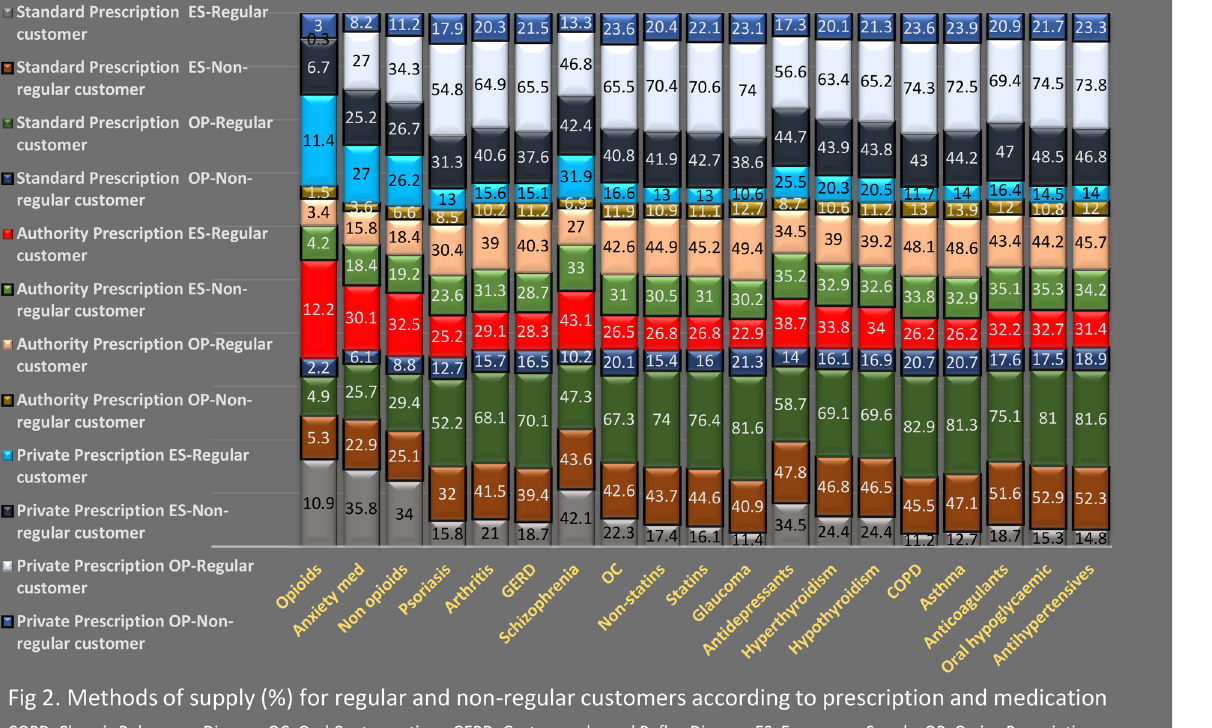
Fig 2. Method of supply (%) for regular and regular customers according to prescription and medication